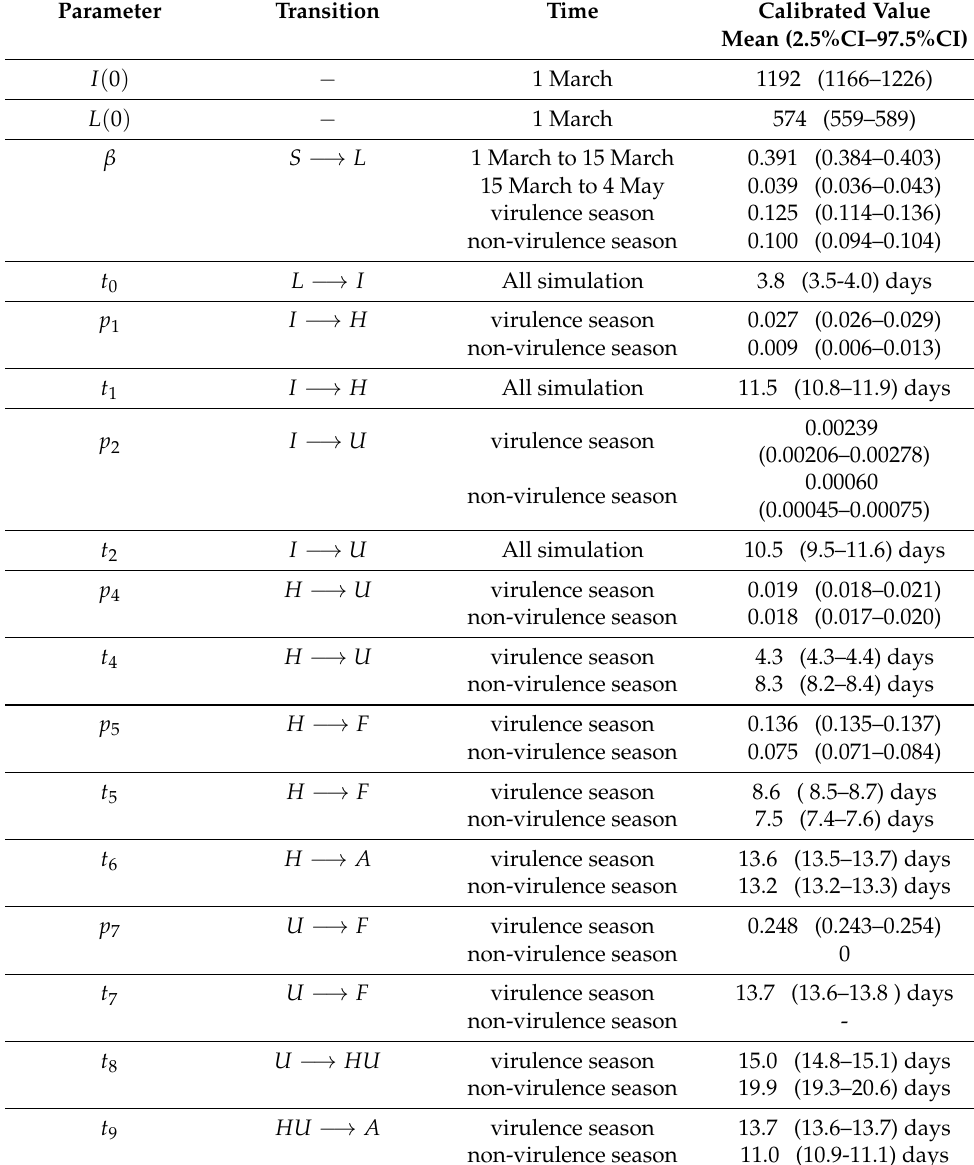
Table 3. Summary of the calibrated model parameter values and their